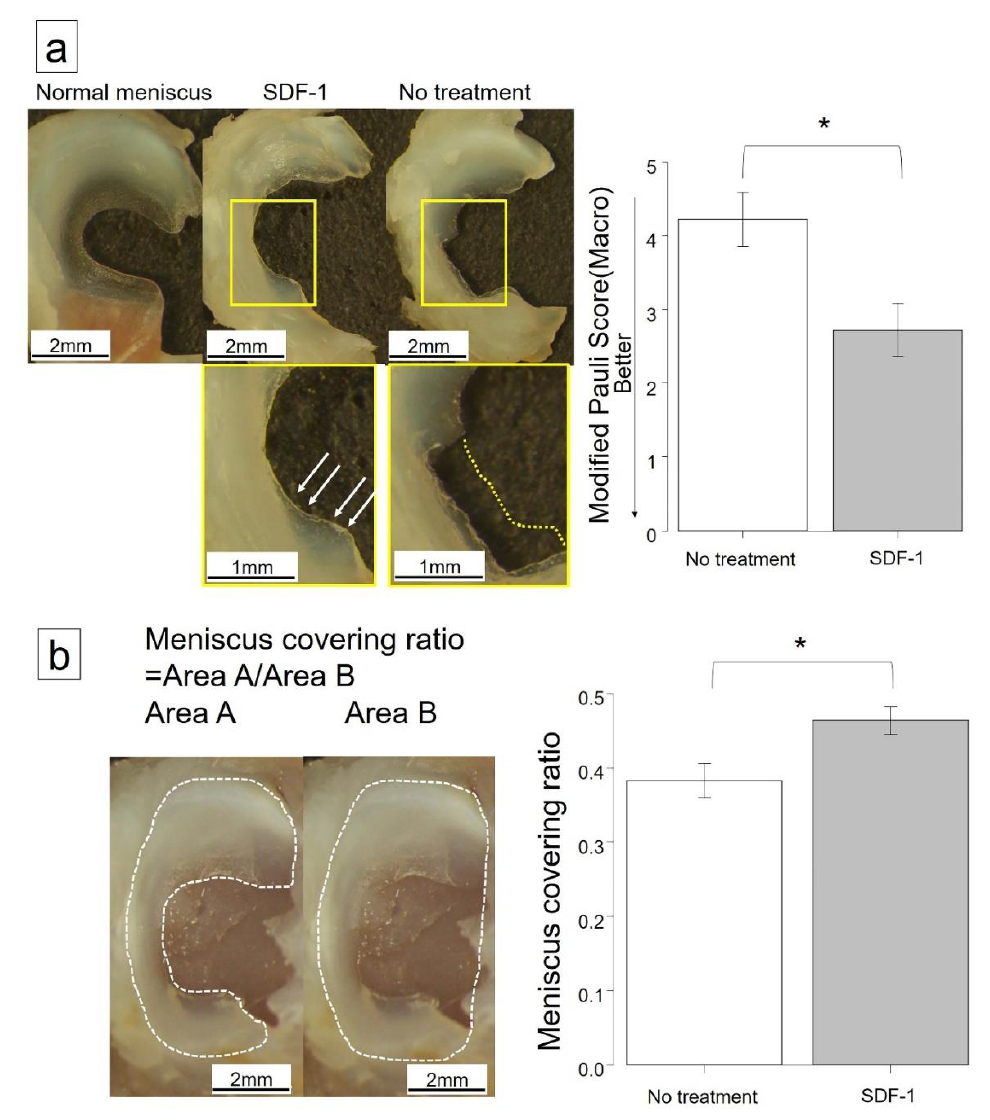
Figure 1. Macroscopic examination of regenerated meniscus at 6 weeks postoperatively. ( a ) Macroscopic observation. The stromal-cell-derived factor-1 (SDF-1) group appeared more regenerated at 6 weeks after meniscectomy (white arrows). The yellow dotted line shows the edge of the original meniscus. Pauli’s macroscopic score was significantly lower in the SDF-1 group than in the no-treatment group (2.71 vs. 4.22, p = 0.026). ( b ) Explanation for meniscus covering ratio, defined as the ratio of medial meniscus area (white dots of Area A) to medial plateau area (white dots of Area B). The meniscus covering ratio was larger in the SDF-1 group than in the no-treatment group at 6 weeks after meniscectomy (0.48 vs. 0.37, p = 0.018). Bars represent the mean ± SD ( n = 7). * p < 0.05.